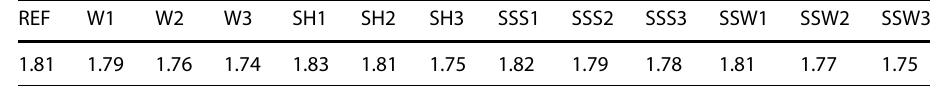
Table 4 Measured density (g/ cm 3 ) at 56 days of curing